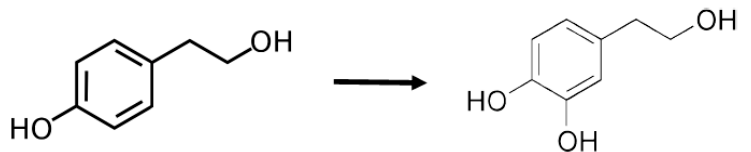
Figure 2. Chemical structures of TYR and HXT: phenolic compound from olive leave and olive oil. TYR: tyrosol (left); HXT: hydroxytyrosol (right).